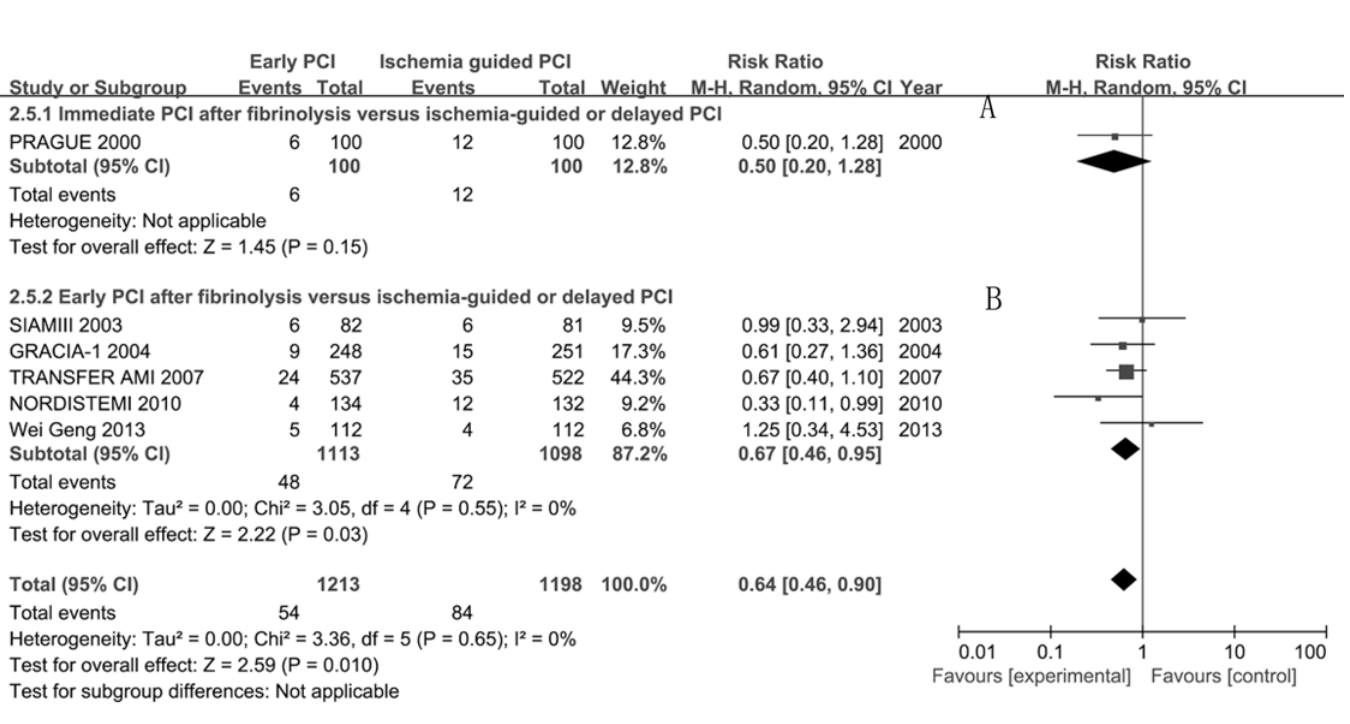
Fig 7. Long-term re-infarction for immediate or early percutaneous coronary intervention (PCI) after fibrinolysis versus ischemia-guided or delayed PCI.